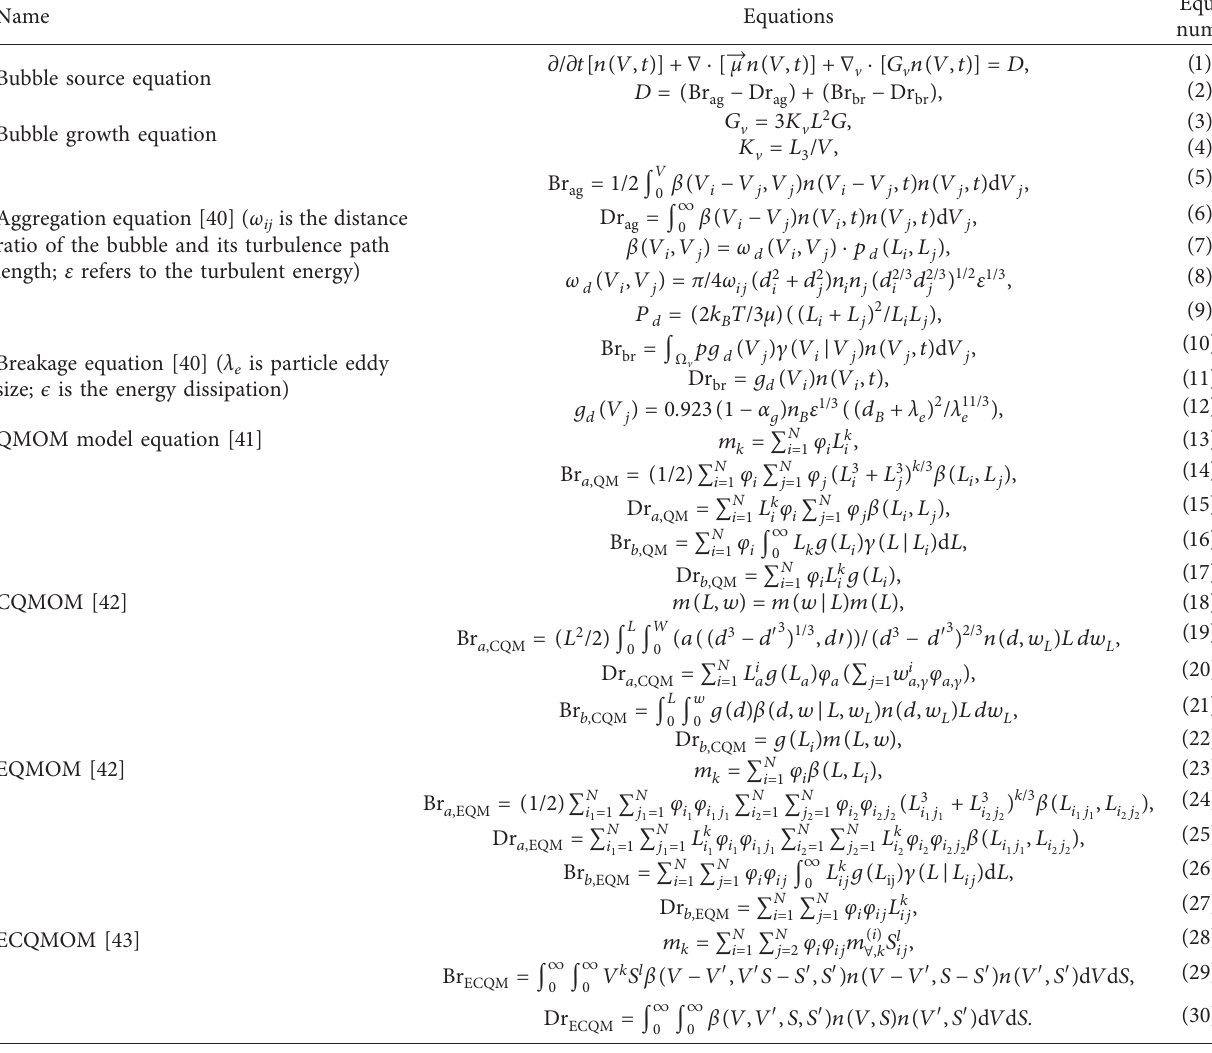
Table 1: The equations for PBM model.